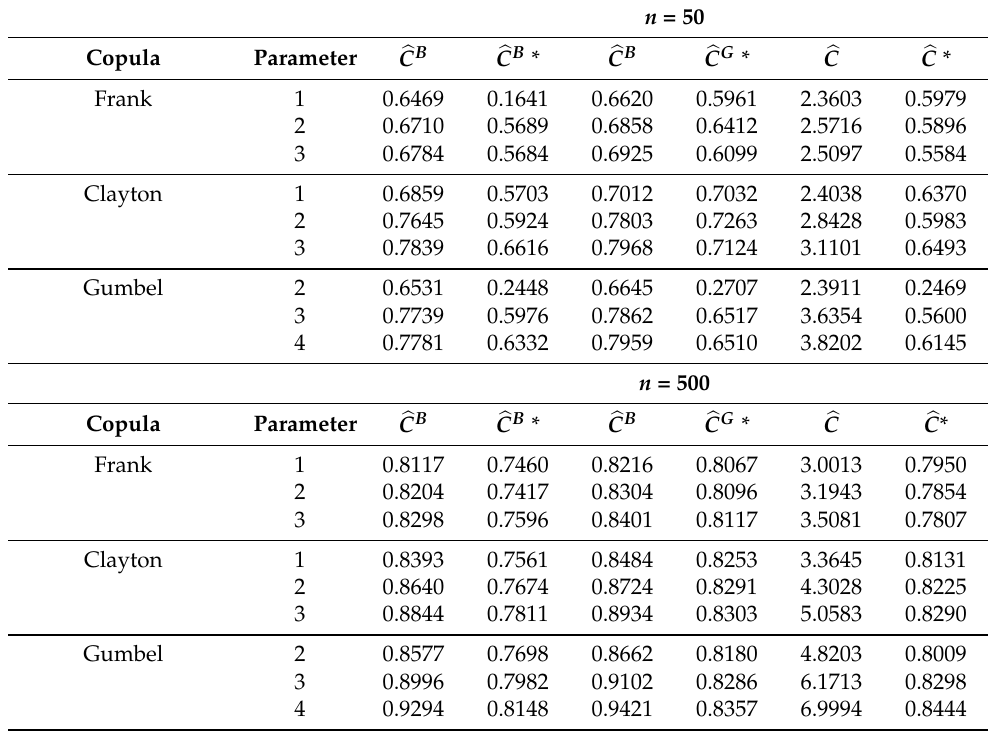
Table 2. Quotient between the approximate MISE of kernel estimators of the copula (numerator) and approximate MISE of the empirical copula (denominator) for archimedean copulas (* indicates optimal